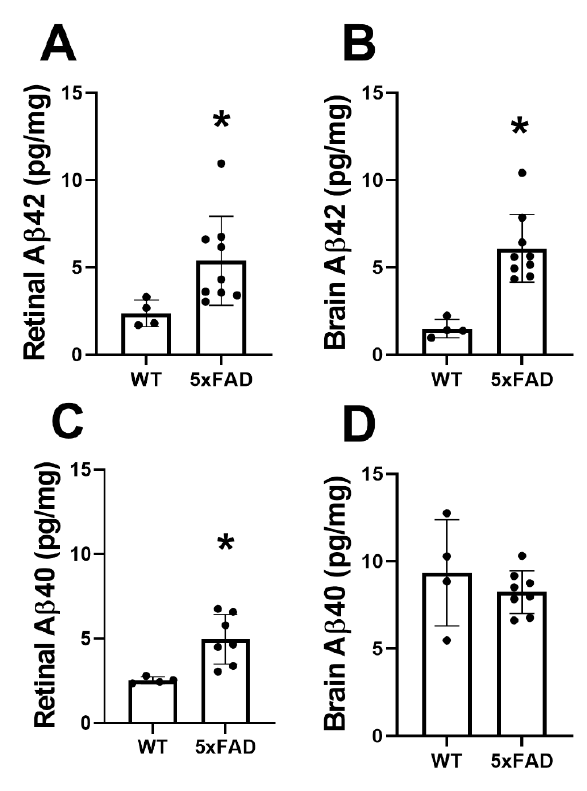
Figure 5. Amyloid-beta (A β ) protein levels in retinas and brains of wild-type (WT) and five-familial Alzheimer’s disease (5XFAD) mice. A β 42 levels in the ( A ) retina and ( B ) brain. A β 40 levels in the ( C ) retina and ( D ) brain. The data are presented as mean ± SD. * p < 0.05.